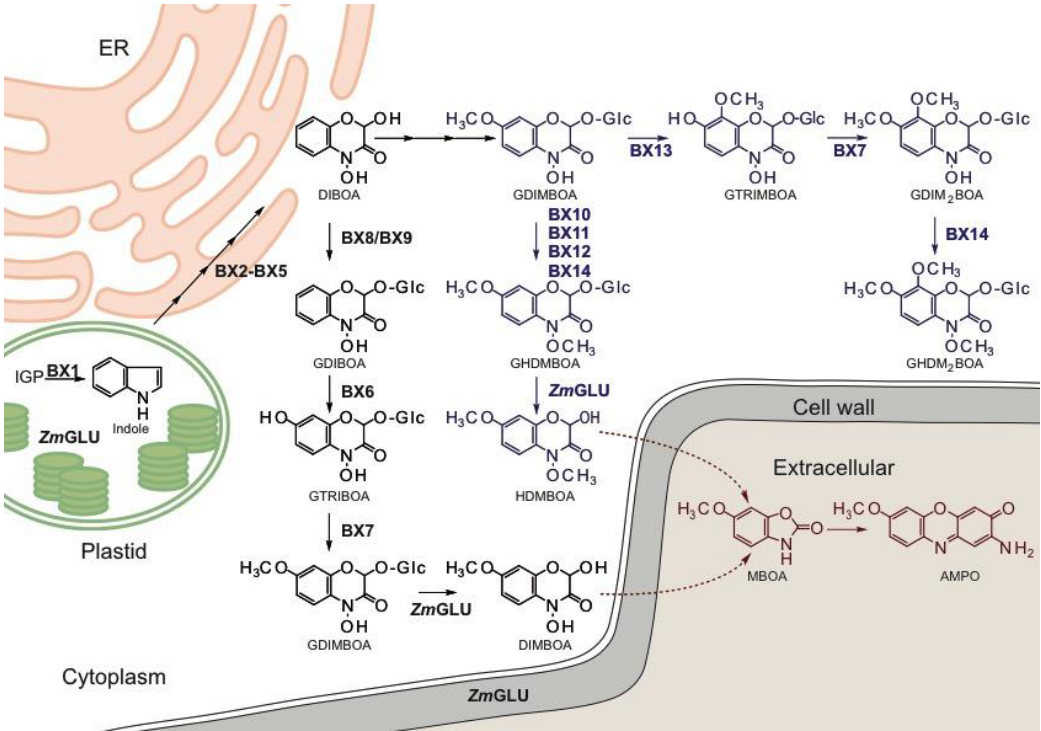
Figure 1. Biosynthesis of benzoxazinoids (BXs) as determined for maize. Compounds and enzymes of the core pathway are depicted in black. Depending on developmental stages and biotic interactions, modifications of BXs are induced. The resulting compounds and the employed enzymes of the inducible branches are coloured in blue. The enzymes locate to the plastid (BX1), to the endoplasmic reticulum membrane (BX2 to BX5), and to the cytosol (BX8 and BX9, BX6, BX7, and BX10 to BX14). The glucosides might be stored in the vacuole and hence are protected against the specific glucosidase, which is found in the plastid and associated with the cell wall. When the cell is disrupted, the glucosides come in contact with the glucosidase and the aglucons are generated. 2,4-dihydroxy-7-methoxy-1,4-benzoxazin-3-one (DIMBOA) and 2-hydroxy-4,7-dimethoxy-1,4-benzoxazin-3-one (HDMBOA) are unstable and the degradation product 6-methoxy-2-benzoxazolinone (MBOA) is spontaneously formed in a watery solution (red colour). Enzymatic transformation by microbes, especially in the soil, yields further catabolites, e.g., stable amino-phenoxazinones such as 2-amino-7-methoxy-phenoxazin-3-one (AMPO). Indole-3-glycerol phosphate (IGP). In cereal crops, (G)DIMBOA (e.g., maize, wheat) and (G)DIBOA (wild Hordeum species) are prevalent in unstressed plants. A distinction in the dominating BXs is found in rye; in aboveground